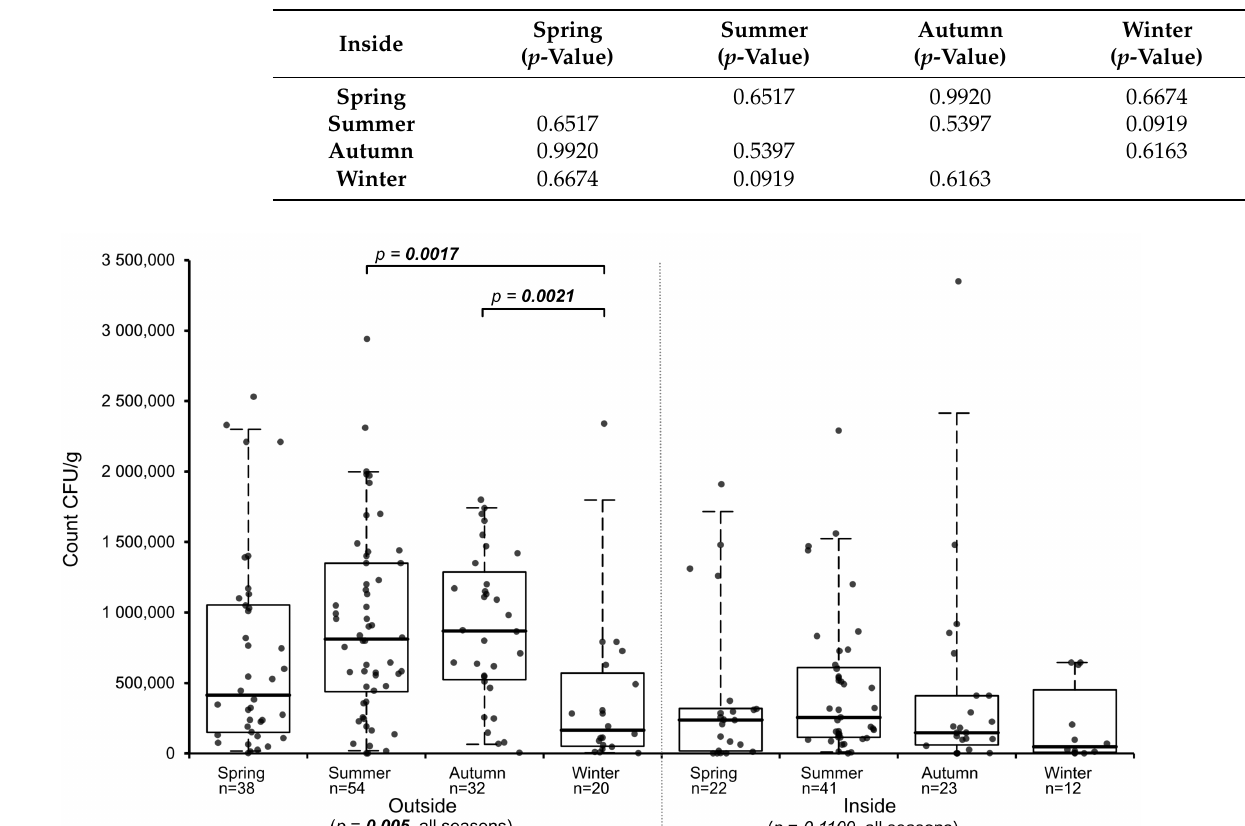
Table 2. Multiple comparisons (Steel—Dwass—Critchlow—Fligner post hoc test) of seasonal Basid- iobolus spp. counts in gecko droppings collected from the inside.